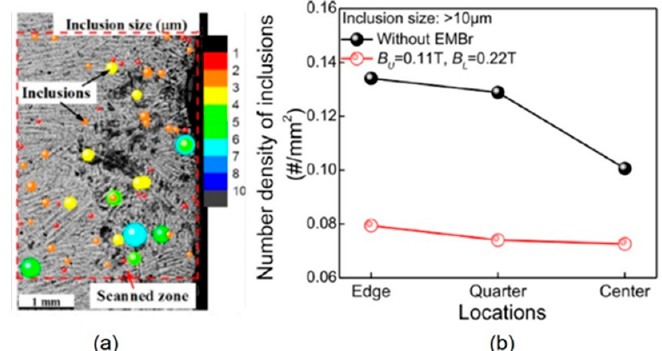
Figure 22. Captured bubble size distribution showing ( a ) the variation with distance beneath the strand surface and ( b ) the effect of double-ruler EMBr on capture fraction [138].